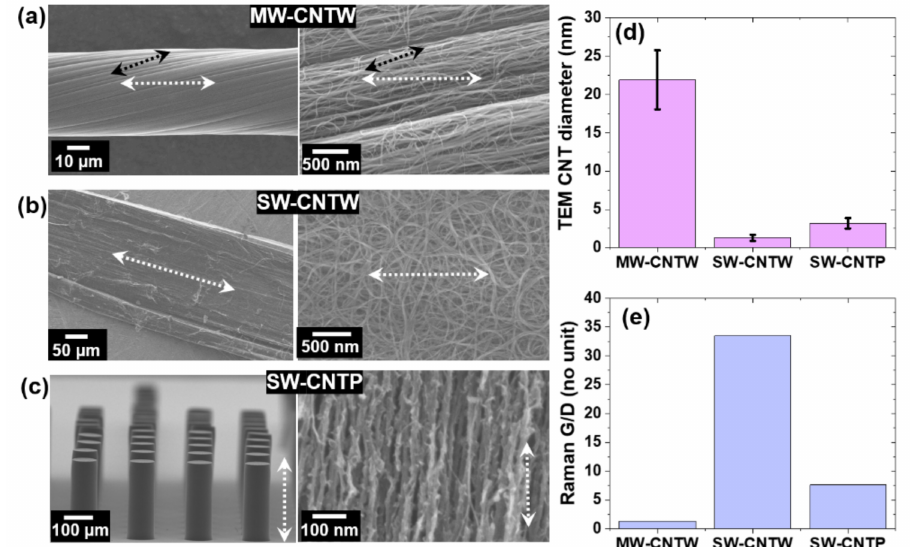
Figure 2. Characterization of CNT templates used for CNT/Cu fabrication. Low- and high- magnification SEM images of ( a ) MW-CNTW, ( b ) SW-CNTW, and ( c ) SW-CNTP samples. White arrows indicate wire/pillar axis. Black arrows in ( a ) indicate twist direction. ( d ) TEM CNT diameter and ( e ) Raman G/D ratios of MW-CNTW, SW-CNTW, and SW-CNTP